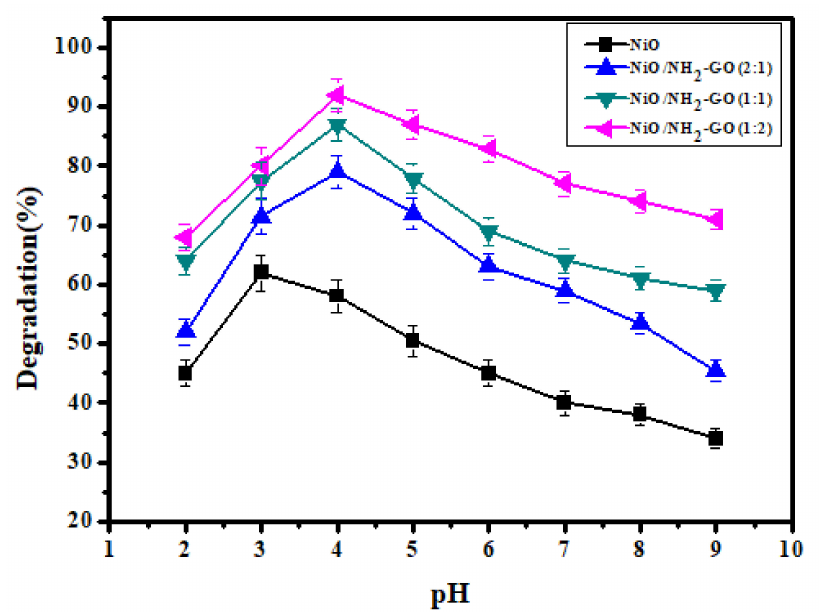
Figure 5. Effect of solution pH on photocatalytic degradation of MO using NiO and its composites with NH 2 -GO (reaction conditions = MO = 25 ppm, catalyst dose = 80 mg/100 mL, light source = UV 254 nm, H 2 O 2 = 10 mM).